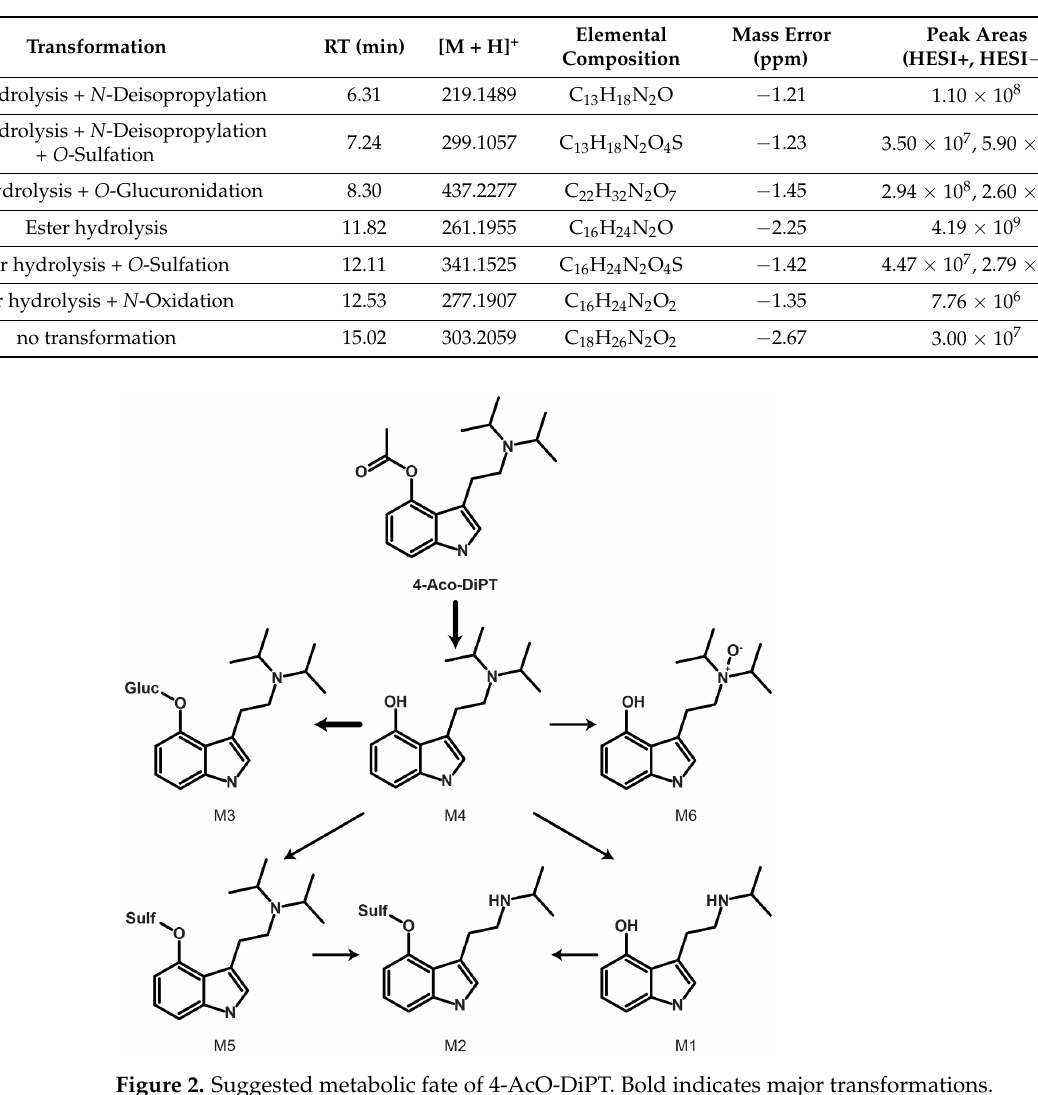
Table 2. Metabolic transformation, retention time (RT), accurate mass of molecular ion (hydrogen adduct in positive-ionization mode [M + H] + ), elemental composition, deviation from theoretical accurate mass, and liquid chromatography–high-resolution mass spectrometry peak area of 4-AcO- DiPT and metabolites after 3 h incubation with human hepatocytes (HESI positive mode, HESI negative mode).